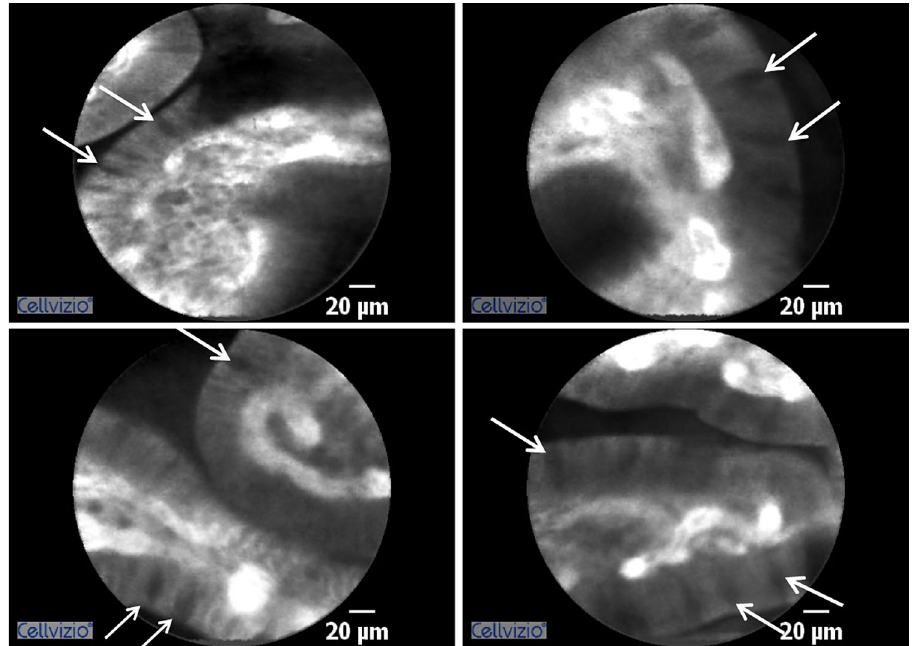
Figure 3. Representative pCLE images of the gastric mucosa of patients affected by atrophic metaplastic autoimmune gastritis (amg). White arrows indicate the presence of globet